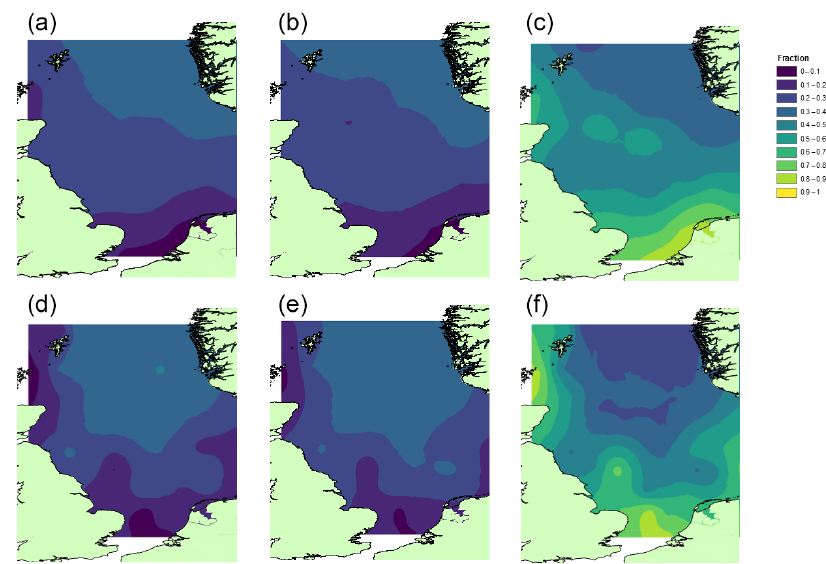
Figure 3. Maps of percentage surface PFT distribution during the summer IBTS cruises of 2010 (upper maps, a–c ) and 2011 (lower maps, d–f ) for pico-phytoplankton (a, d) , nano-phytoplankton (b, e) and micro-phytoplankton (c, f)